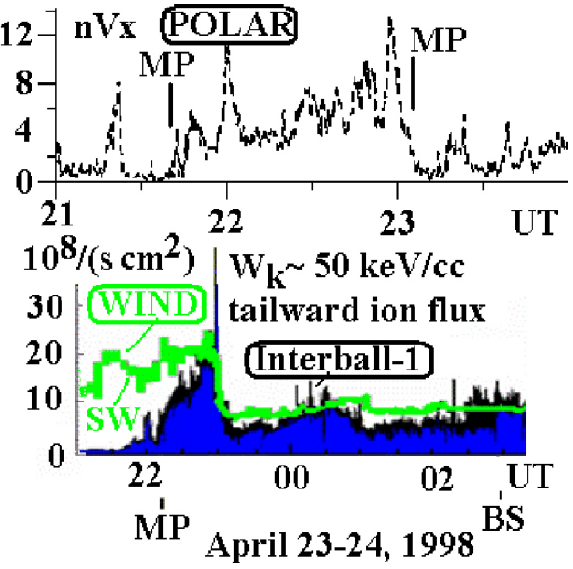
Fig. 4. 23 April 1998. Top panel: antisunward ion flux nV x in 10 8 s − 1 cm − 2 ) as seen by Polar at (6, − 1, 4) R E GSM). Bot- tom panel: antisunward ion flux nV x in (10 8 s − 1 cm − 2 ) as seen by Interball-1 at (2, − 4, 8) R E GSM (blue shadowed black line) and by WIND (thick green line, time-lagged from L1 to